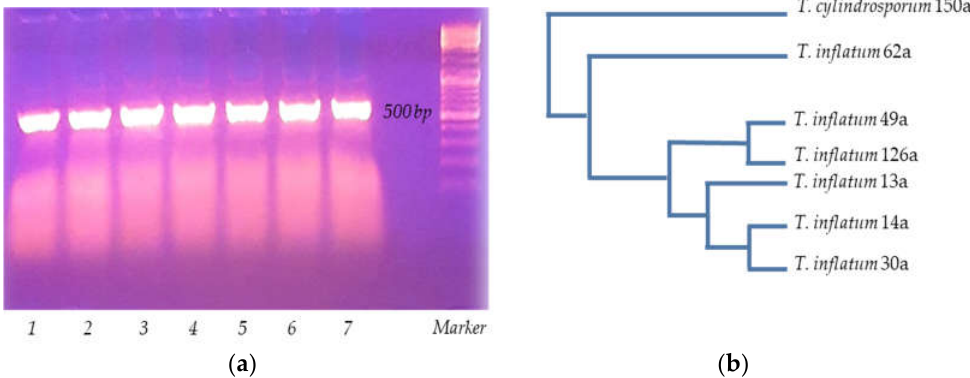
Figure 1. White Sea micromycete isolate identification ( a ) PCR analysis 1—13a, 2—14a, 3—126a, 4—49a, 5—150a, 6—62a, 7—30a.; ( b ) phylogenetic tree of obtained Tolypocladium strains. Table 1. Tolypocladium strains obtained from White-Sea-soil identification.